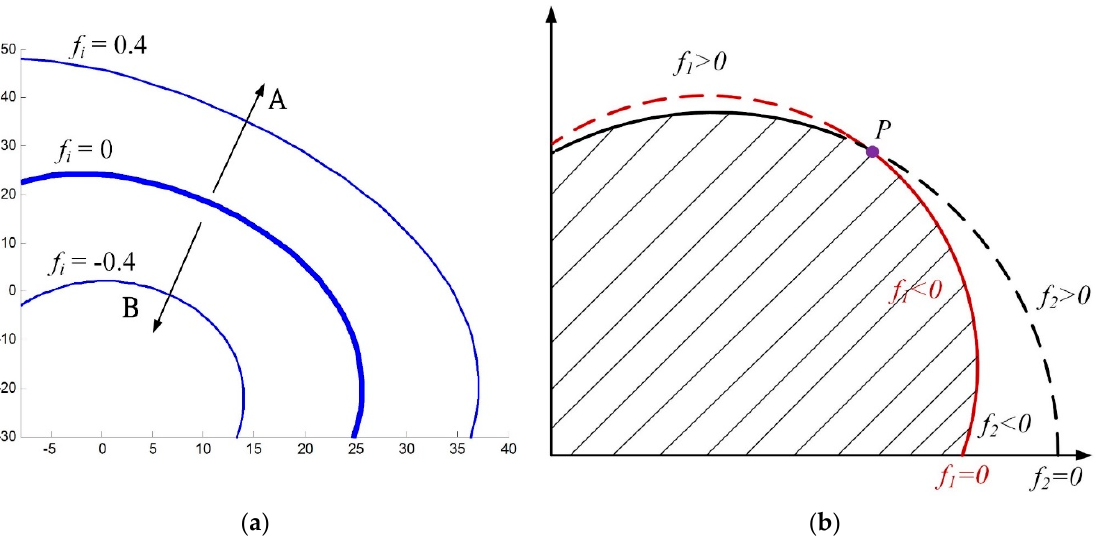
Figure 5. External contour region recognition method. ( a ) Workpiece region and environmental region. ( b ) Workpiece cross − sectional contour.